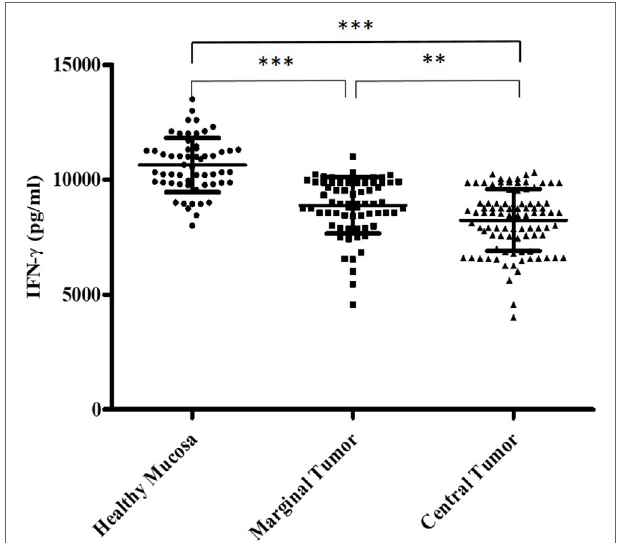
FigUre 3 | The different interferon (IFN)- γ amount (pg/ml) secreted by the T cell clones with T helper1 cells (Th1) profile, isolated from the tumor tissue. We measured the interferon (IFN)- γ production in culture supernatants by specific test ELISA. Th1 cell clones isolated from healthy mucosa significantly produced higher IFN- γ amount compared to that produced by Th1 cell clones generated from both marginal and central tumor. The error bars represent the SD. Statistical analyses were calculated using one-way ANOVA and Turkey’s post hoc . The asterisks (*) represent p -values, * p < 0.05, ** p < 0.01, *** p < 0.001.